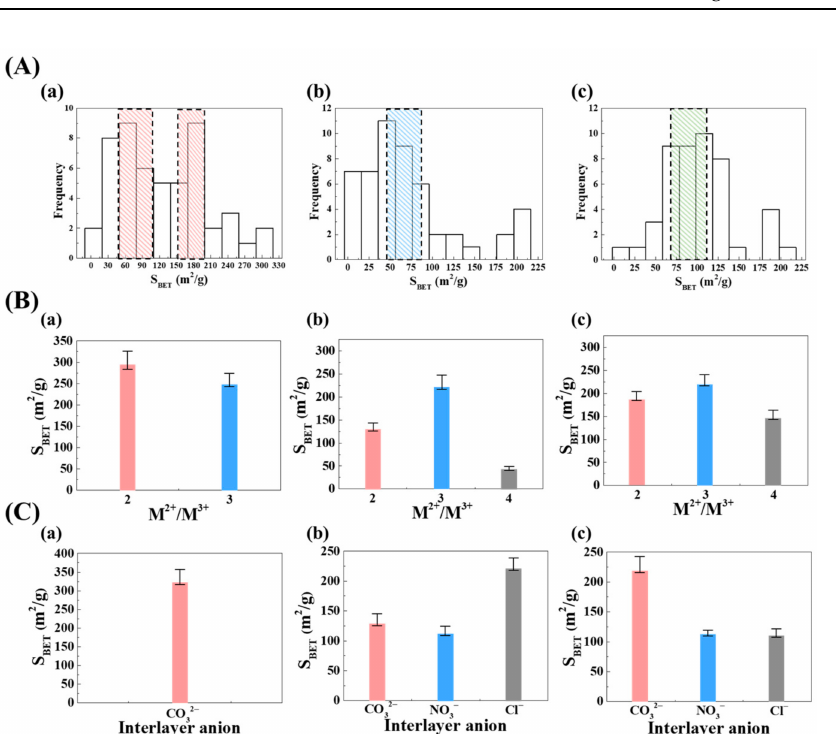
Figure 1. ( A ) Histogram for the specific surface are values of depending on metal composition. Dotted box stands for the most frequently reported value domain. ( B ) Average S BET and standard deviation of three MMOs depending on metal ratio, ( C ) Average S BET and standard deviation of three MMOs depending on interlayer anion. ( a ) MgAl-MMO, ( b ) ZnAl-MMO, and ( c ) MgFe-MMO. The graphs in ( B , C ) were prepared with selected values from the literature used in ( A